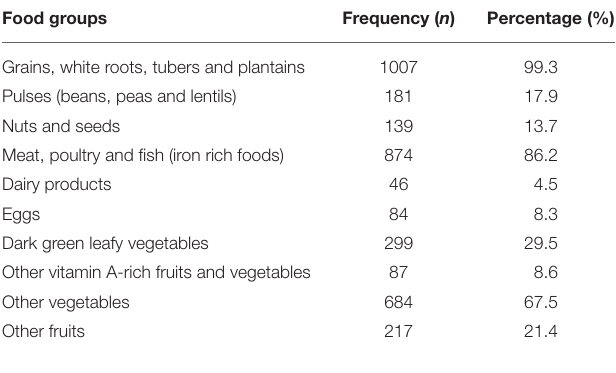
TABLE 2 | Proportion of the different food groups consumed by the study participants 24-h prior to survey.